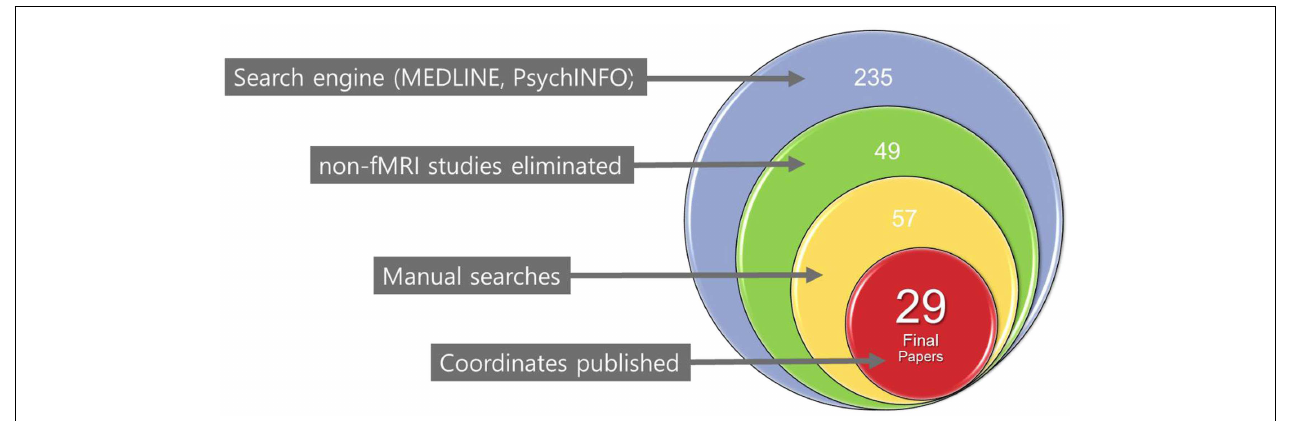
FIGURE 1 | Flow chart of the literature search for included studies